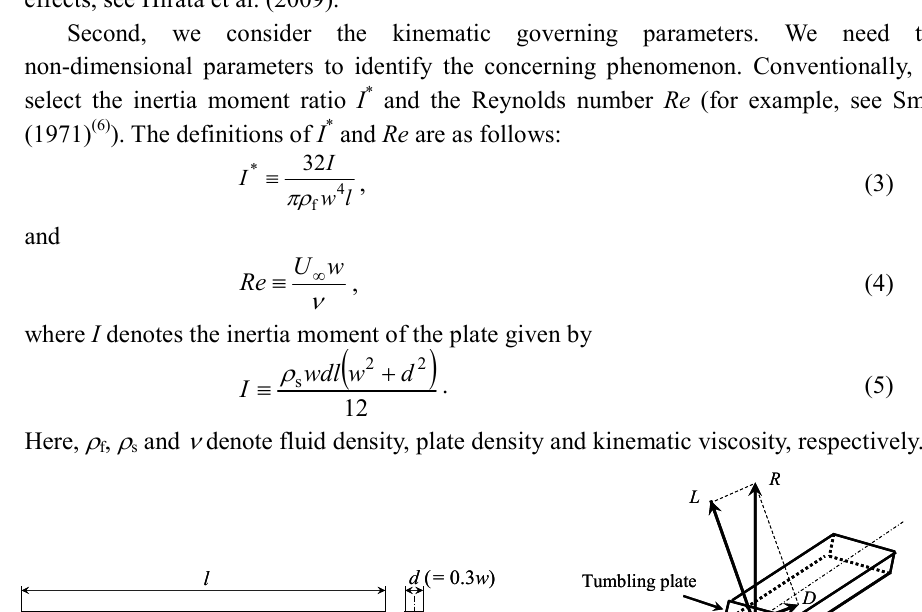
l d ( = 0.3 w ) l d ( = 0.3 w ) Fig. 1 Tumbling plate; a prism with a rectangular cross section.